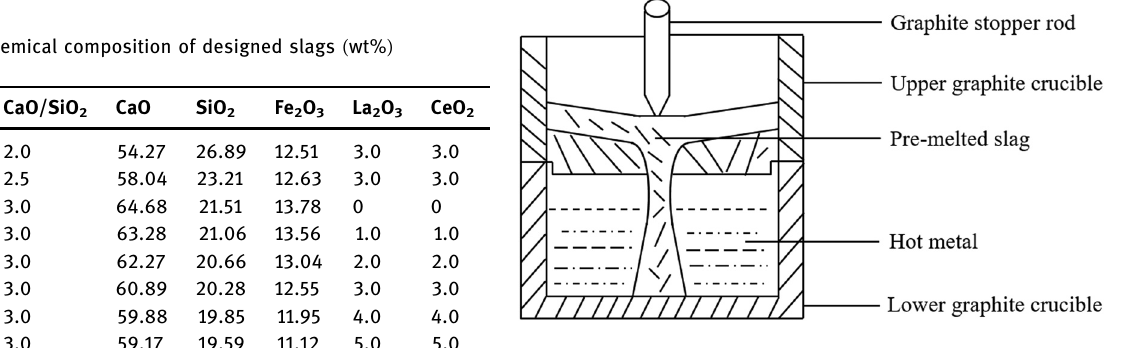
Figure 1: Schematic diagram of dephosphorization test with double - layer graphite